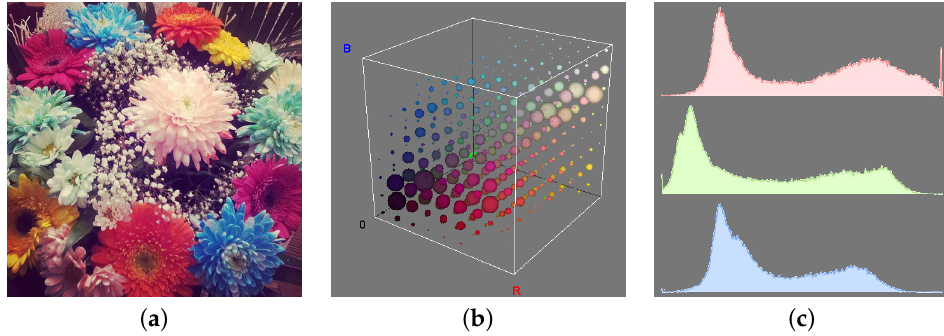
Figure 7. Colour histograms in the RGB space. From left to right: sample image ( a ), three-dimensional colour histogram ( b ) and marginal histograms ( c ). Sample image ( a ) sourced from Wikimedia Commons (https://upload.wikimedia.org/wikipedia/commons/thumb/d/dc/Bunch_of_flowers_